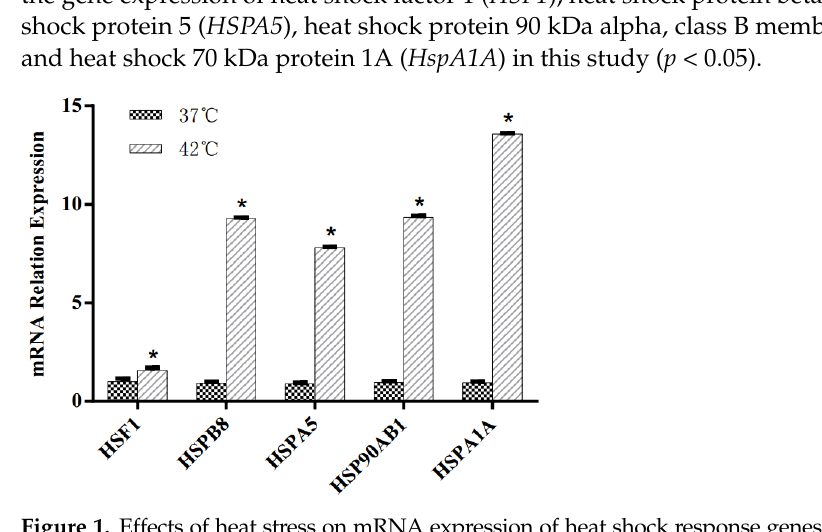
Figure 1. Effects of heat stress on mRNA expression of heat shock response genes in MAC-T bovine mammary epithelial cells. Asterisks indicated significant differences between different groups: * p < 0.05.